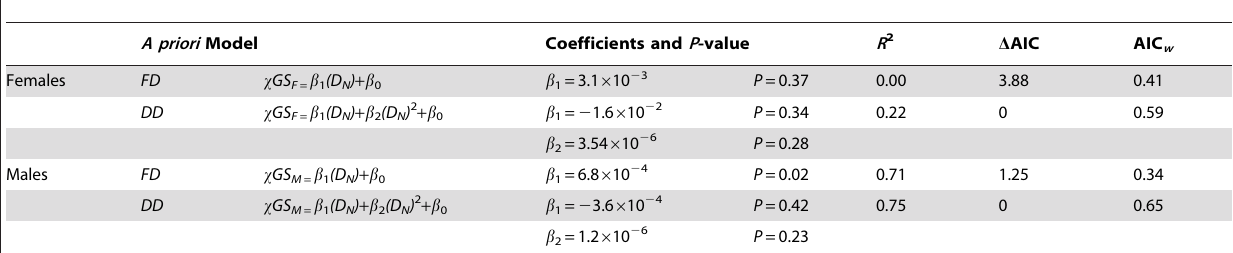
Table 1. Comparison of frequency – ( FD ), and density – ( DD ) response of mean group size xGS ð Þ for female ( F ) and ( M ) elk to population size ( D N ) in Riding Mountain National Park over six years (2002–2004, 2007–2009) during an intentional population